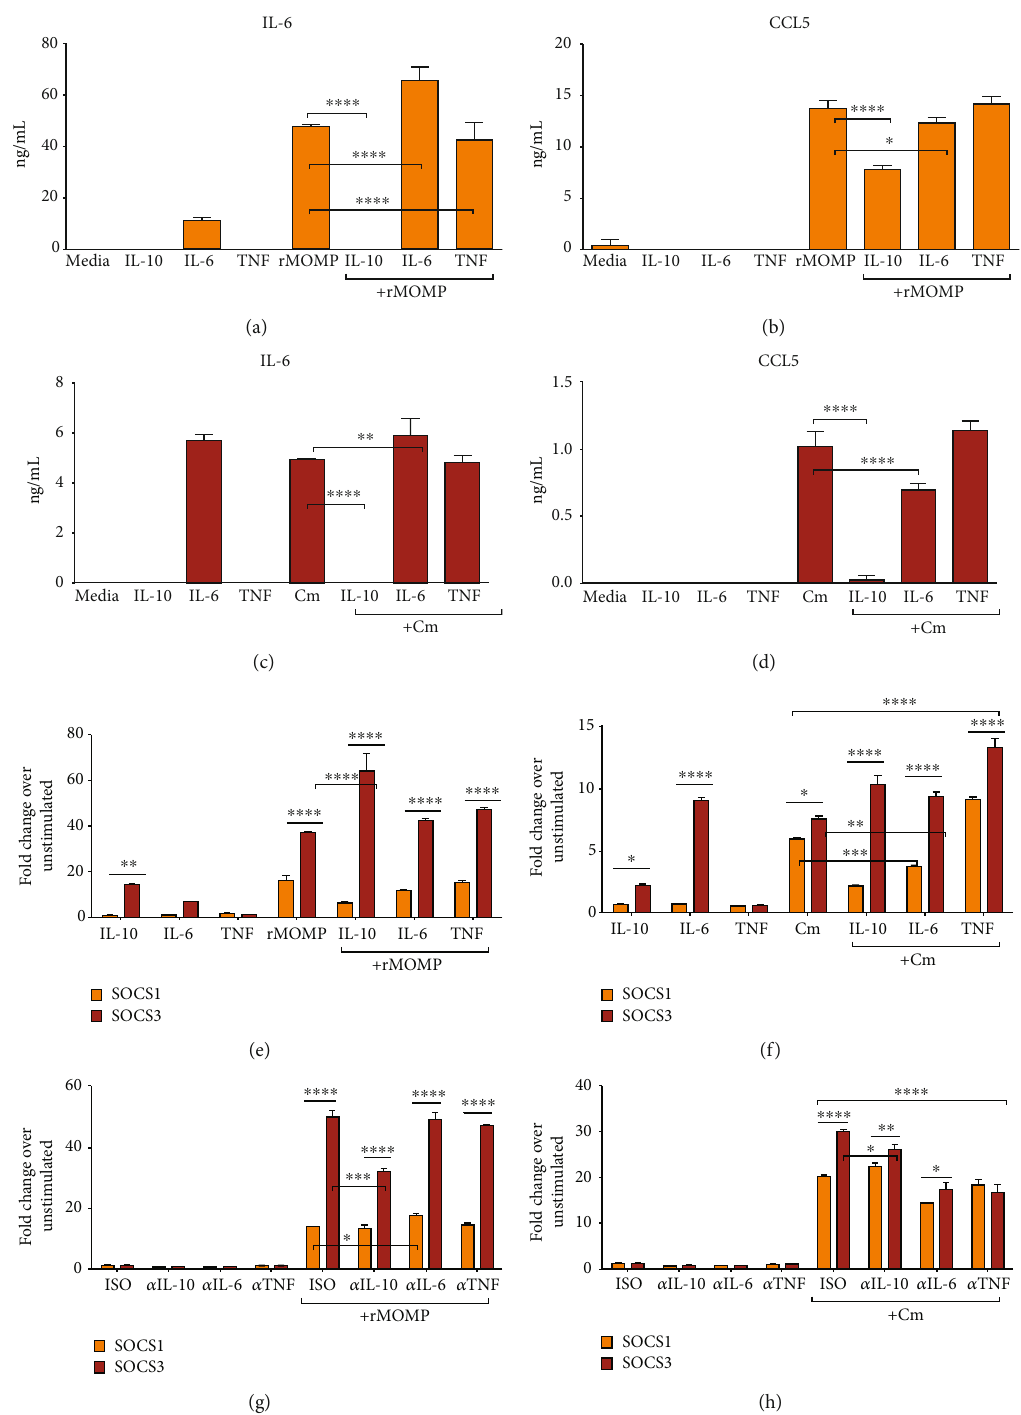
Figure 5: The e ff ect of exogenous and endogenously produced IL-6 and TNF on the expression of in fl ammatory mediators and SOCS in chlamydial-stimulated macrophages. Macrophages (10 6 /mL) were stimulated with rMOMP (10 μ g/mL) or Cm (MOI of 2) in the presence and absence of IL-10, IL-6, and TNF (each at 10ng/mL) for 24 h. RNA and cell-free supernatants were collected to quantify IL-6 and CCL5 (A-D) along with SOCS1 and SOCS3 mRNA gene transcripts (E-F), respectively, by TaqMan qRT-PCR and speci fi c ELISAs. Macrophages were pre-incubated with neutralizing Abs to IL-10, IL-6, and TNF (each at 25 μ g/mL) for 30min before adding rMOMP or Cm for an additional 24h. Normal rat IgG1 Ab served as the isotype control (ISO). RNA was collected to quantify SOCS1 and SOCS3 mRNA gene transcripts (G-H). An asterisk indicates a signi fi cant di ff erence ( P < 0.05), and P values were calculated as described in Figure 1. Each bar represents the mean ± SD of samples run in triplicates. Each experiment was repeated at least 3